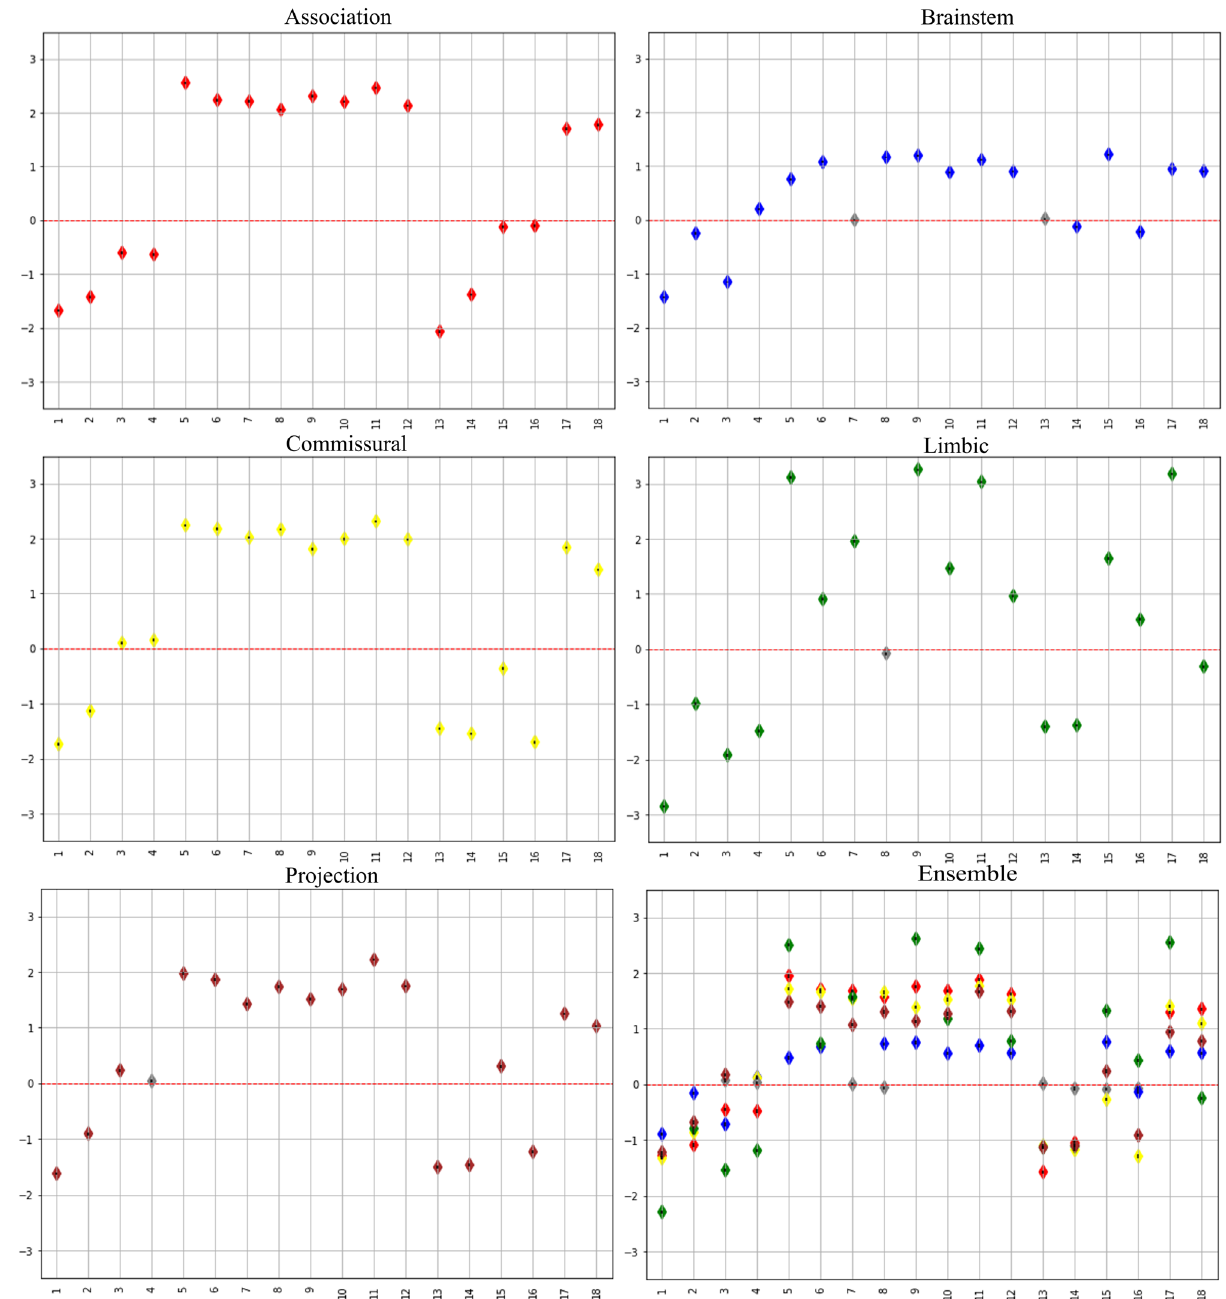
Figure 2. Association of the IDPs and brain-PAD for the different models. For each model, the numbers on the x-axis represents the order of the different IDPs summarised in the legend, while the regression coefficient (the diamond shape represents the beta coefficient) values are reported in the y-axis along with their standard error (the small black dot inside the diamond shape). Grey color indicates non-significant ficient value refers to how many standard deviations a dependent variable (brain-PAD) will change per standard deviation increase in the independent variable (individual IDPs) A highly similar association pattern is apparent across FG, though higher variability was observed for the Limbic FG. More specifically, all the IDPs were signifi- cantly associated with brain-PAD in Association and Commissural groups, while few associations did not reach significance in the other three tract groups, that is: mean L1 and mean ICVF in Brainstem, weighted mean L1 in Limbic and weighted mean MO in Projection fibers. Considering the different imaging variables, anisotropy (FA, ICVF, OD and MO and respective weighted versions) and diffusivity (MD, L1, L2, L3, ISOVF and weighted